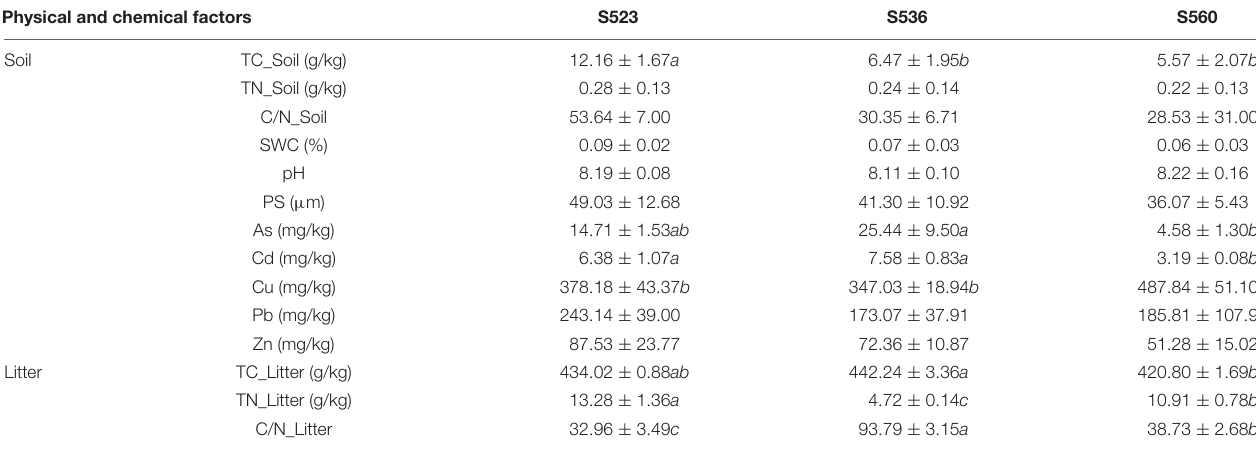
TABLE 1 | Soil and litter properties over progressive phytoremediation